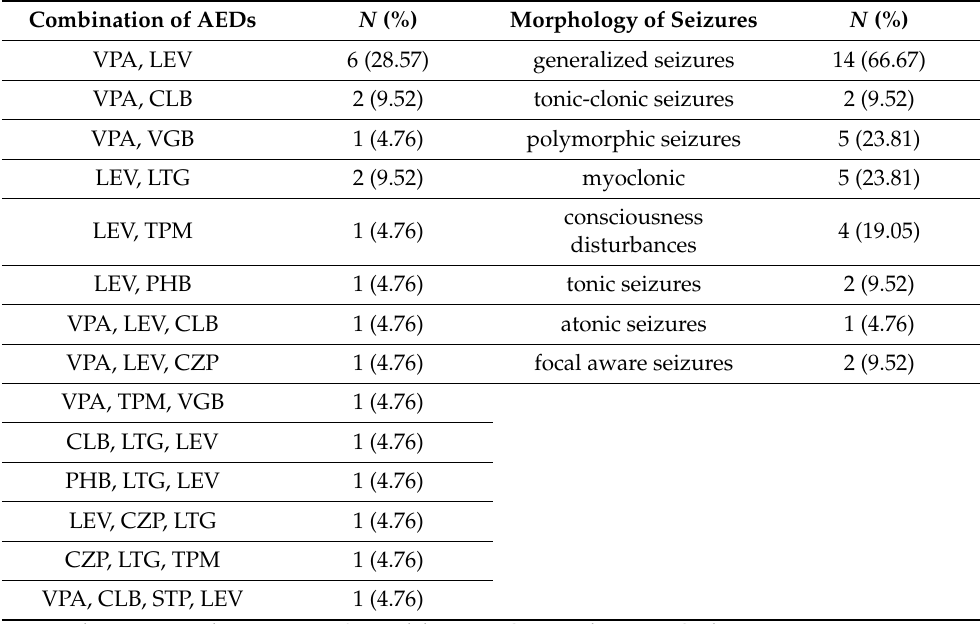
Table 2. The frequencies of AEDs combinations and types of seizures in analyzed children with